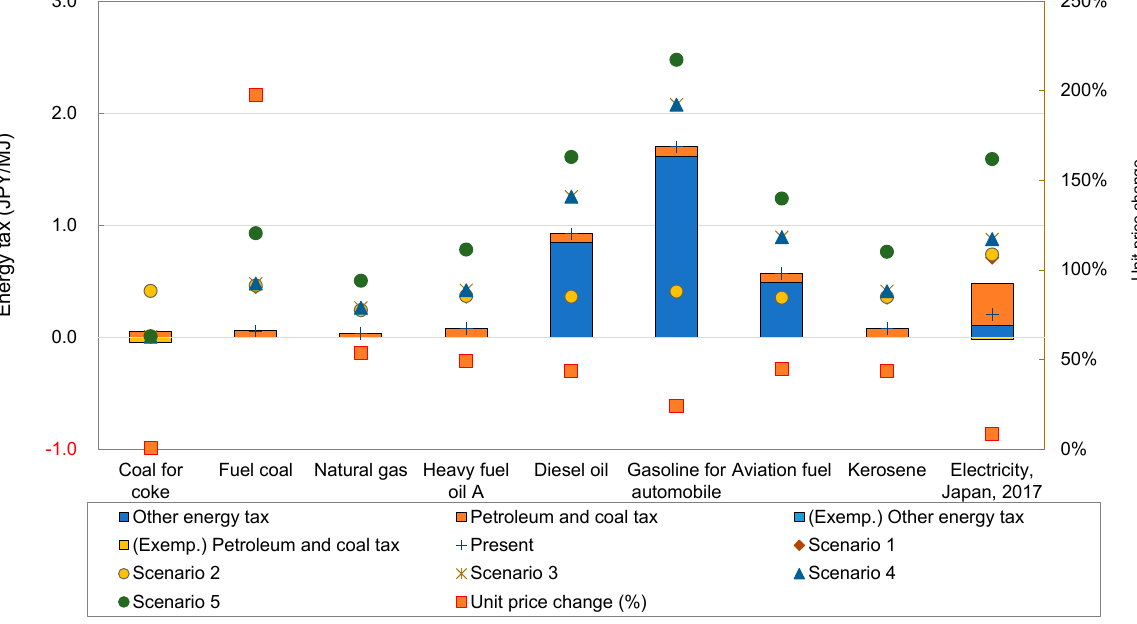
Figure 4. Changes in product taxes and product prices in energy under different taxation scenarios. The bar graphs show the present taxation breakdown. The percentage change in product prices compares the present with Scenario 5.